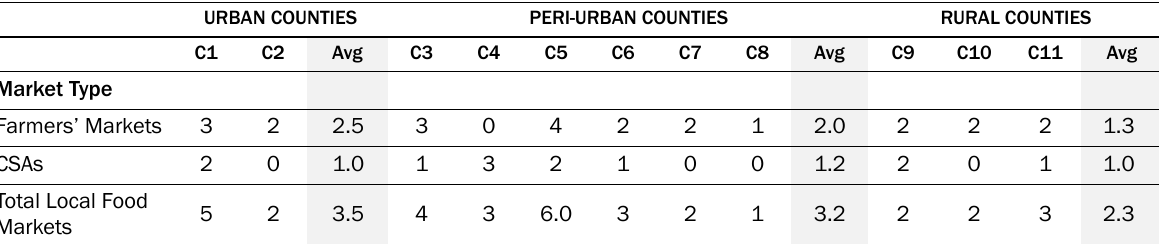
Table 2. County Local Food Market